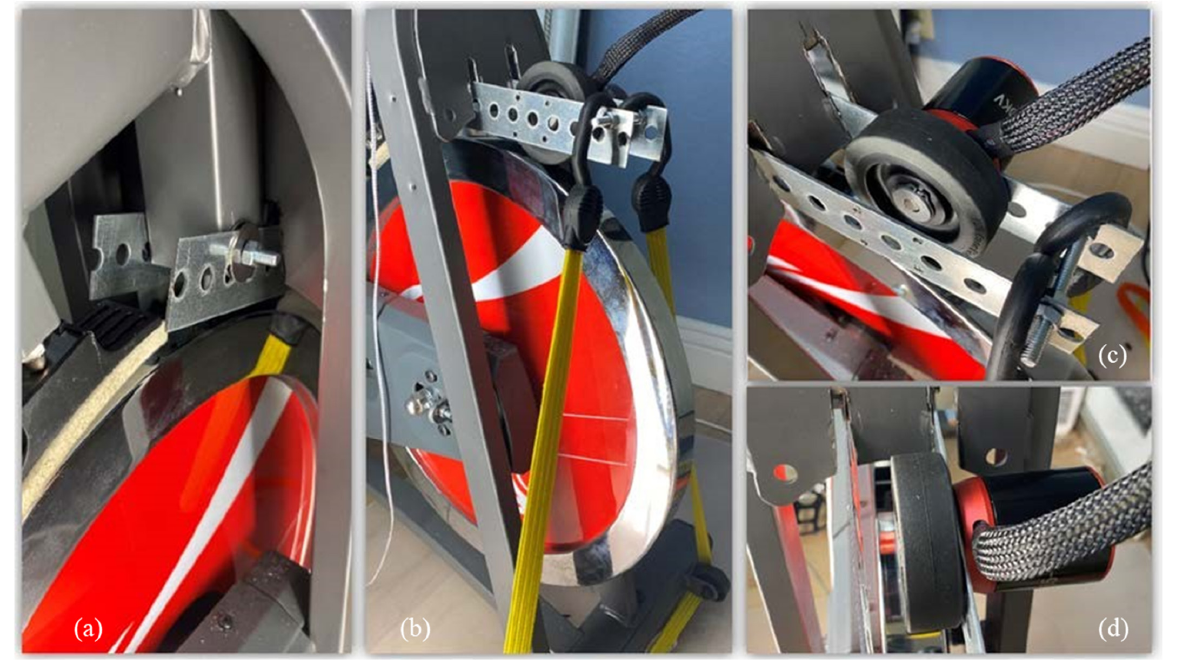
Figure 8. The motor assembly in the prototype ( a ) the modification of the bike frame to mount the motor; ( b ) the friction drive assembly; ( c ) the friction drive and the motor assembly; and ( d ) a closer view of the friction drive with the Motor.